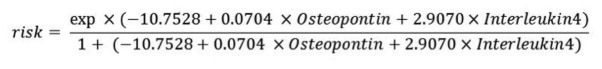
Formula for logistic regression.